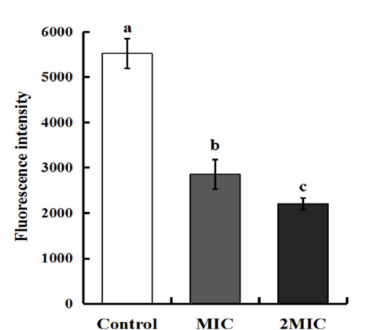
Figure2. E ff ectofMEOonmembranepotentialof S.aureus. Di ff erencelettersmeansstatisticaldi ff erence.